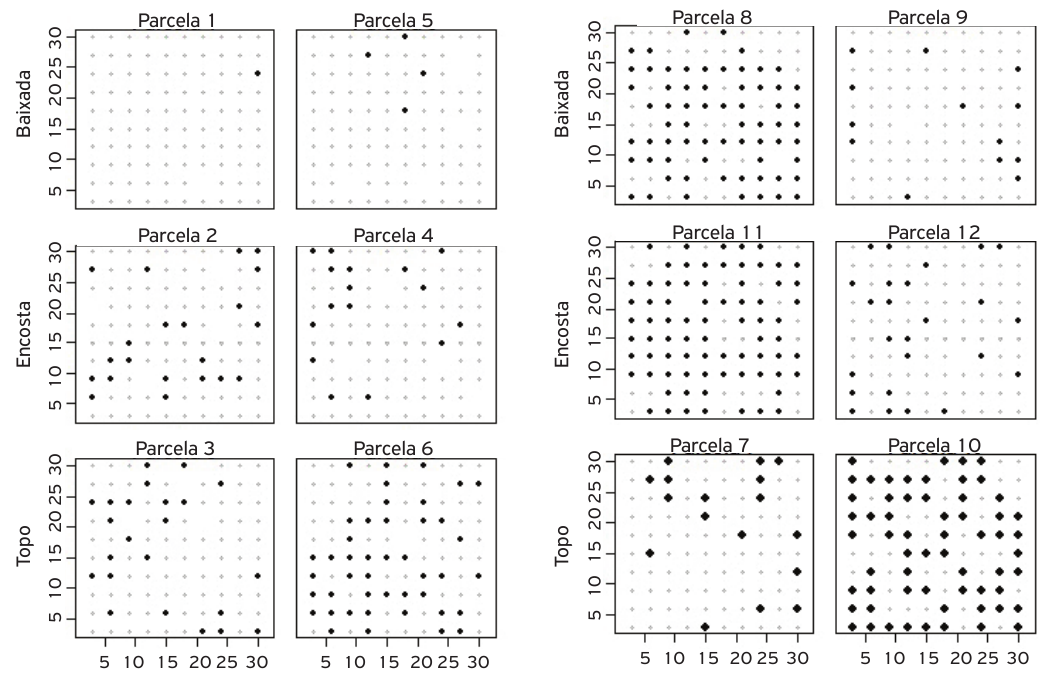
Figura 2. Distribuição do ataque de Heilipodus naevulus (Mannerheim, 1836) em áreas de plantio de clones de eucalipto, plantados sob arranjo espacial de 3 x 3 m, no mês de outubro/2008, nos talhões 21 (7 – 12) e 29 (1 – 6), subdivididos em baixada, encosta e topo. Barão de Cocais